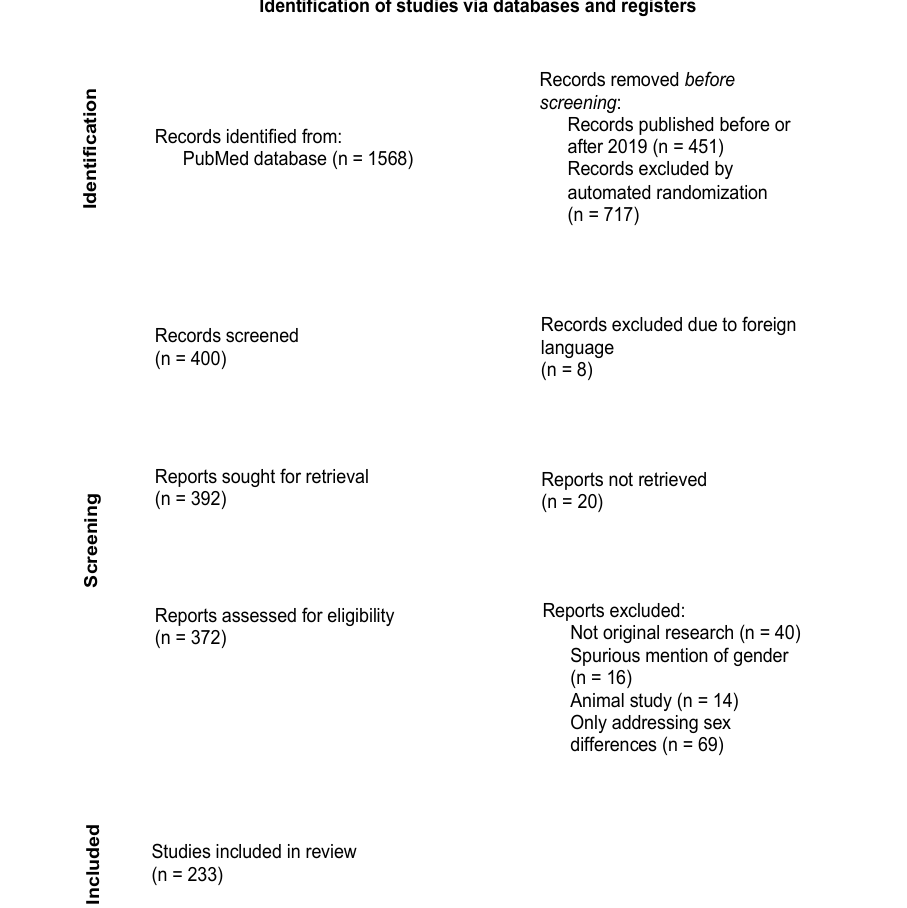
Figure 1. PRISMA chart of included literature.